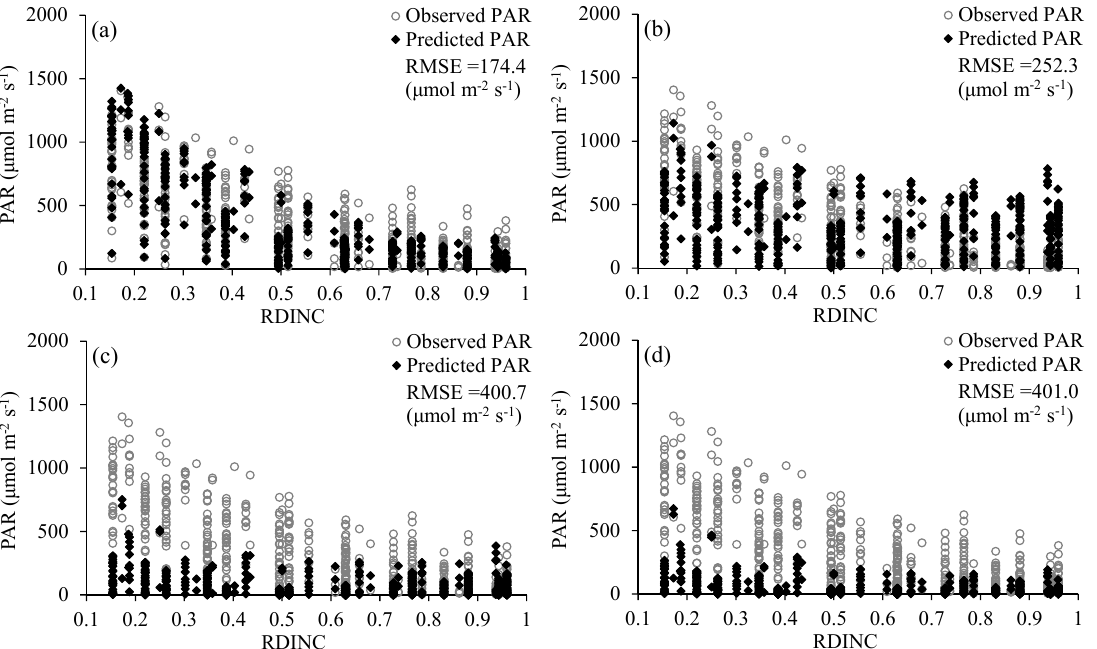
Figure 7. Comparison of the observed and simulated photosynthetically active radiation (PAR) within a crown: ( a ) PAR is simulated with the k model that was constructed in this study; ( b ) PAR is simulated with k values ranging from 0.30 to 0.50 at 0.01 intervals; ( c ) PAR is simulated with k values that were calculated from the empirical equation [60]; and ( d ) PAR is simulated with the k values that were calculated from the empirical equation [61].